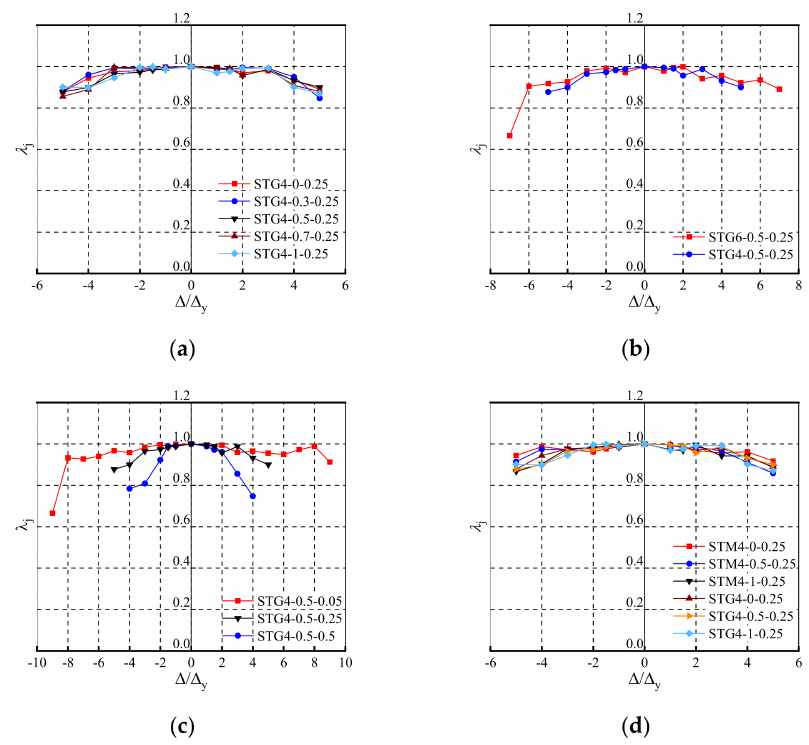
Figure 12. ( a ) Strength degradation coefficient curve λ j - ∆ / ∆ y for different replacement ratios of RBA; ( b ) strength degradation coefficient curve λ j - ∆ / ∆ y for different steel tube thicknesses; ( c ) strength degradation coefficient curve λ j - ∆ / ∆ y for different axial compression ratios; ( d ) strength degradation coefficient curve λ j - ∆ / ∆ y for different cementitious